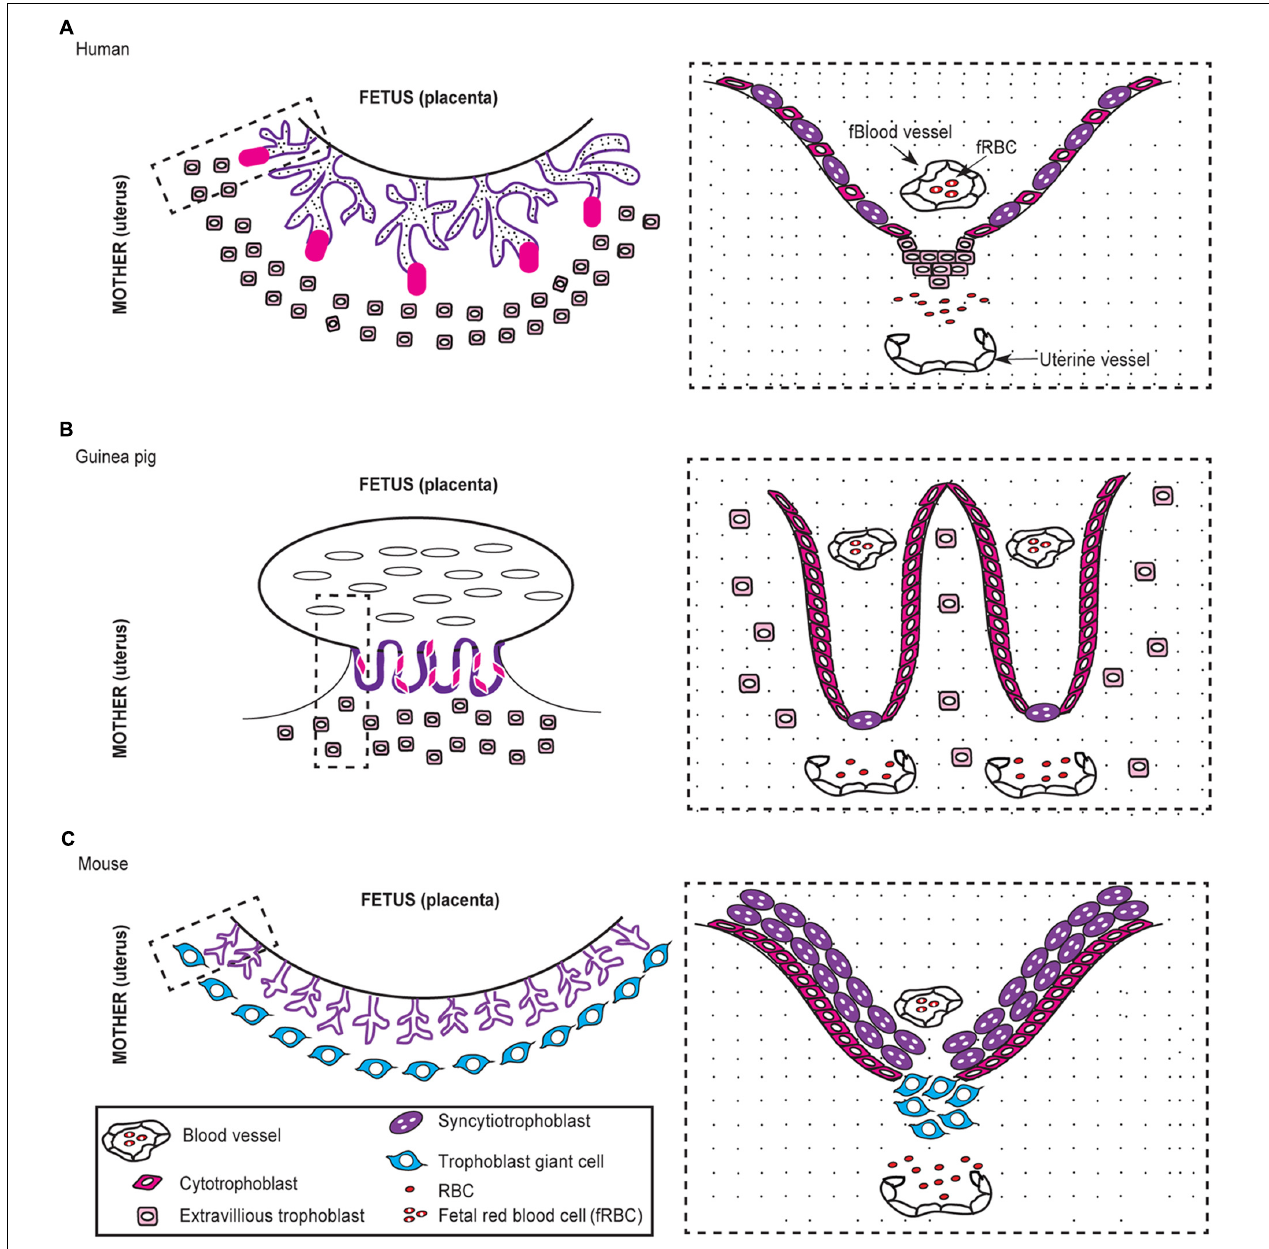
FIGURE 2 | Comparative morphology of the human, guinea, and mouse placenta. The human and guinea pig placenta are hemomonochorial (A,B) while the mouse is hemotrichorial (C) . The dashed rectangle outlines the interface of the fetal-maternal blood supplies, which is shown in higher detail to the right.